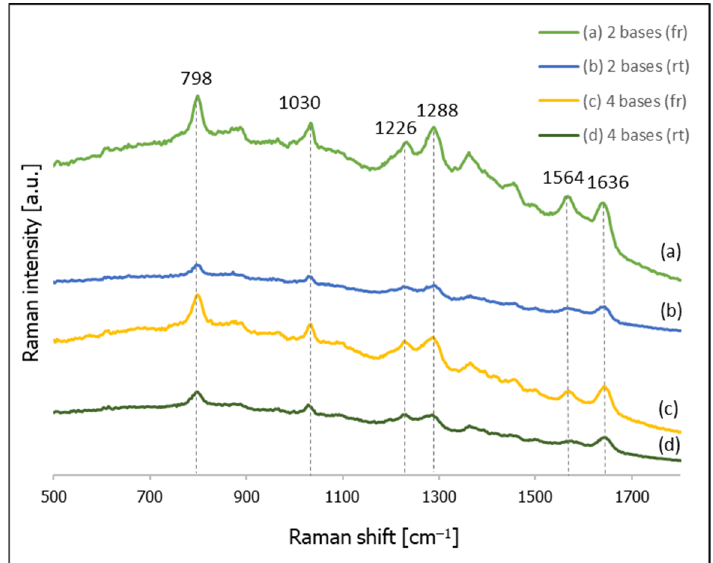
Figure 1. SERS spectra of thiolated DNA on gold nanoparticles: ( a ) CT–(CH 2 ) 6 –SH (with